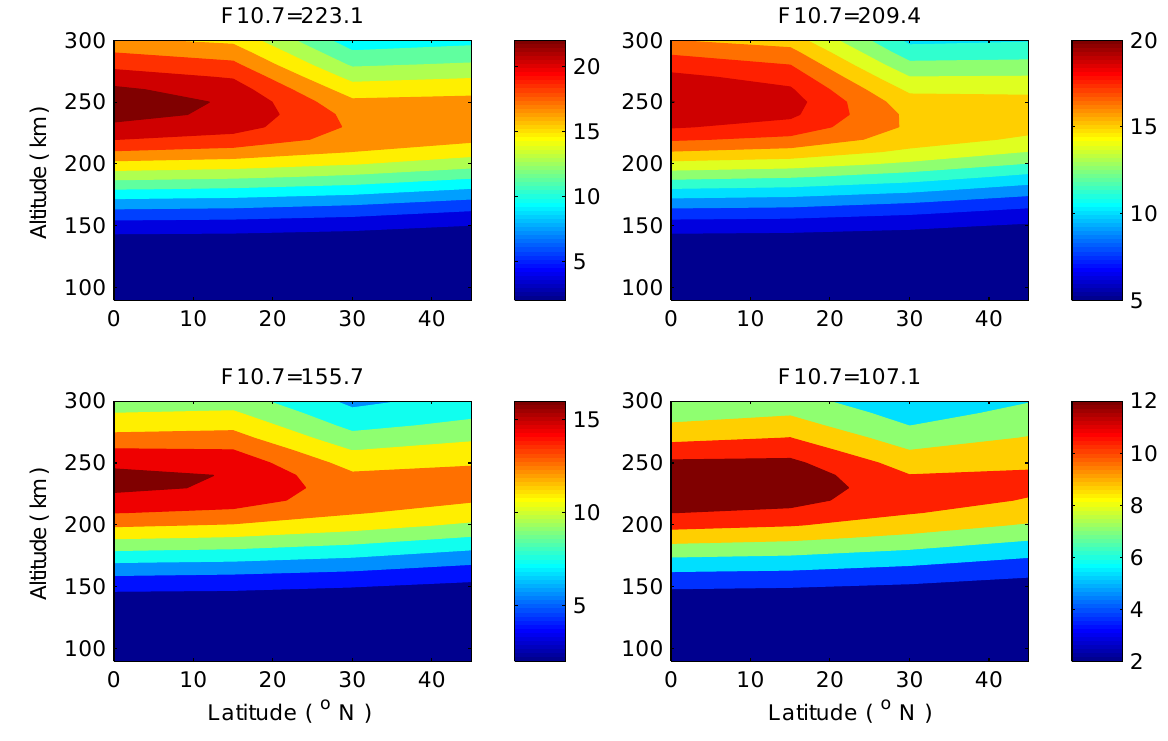
Fig. 5. Modeled morphology of 7320 ˚A between 0 ◦ and 45 ◦ N on 3 April for different solar activity levels at 12:00h local time.